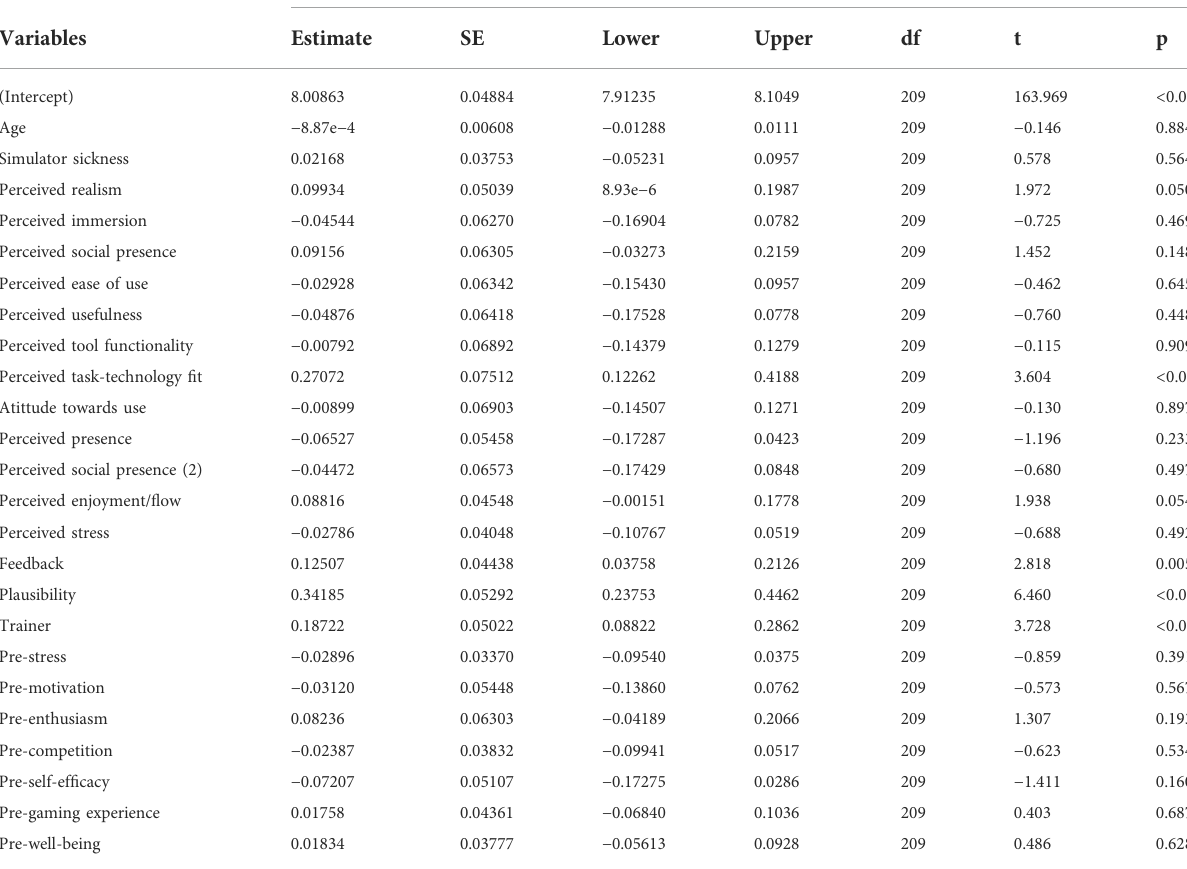
TABLE 7 In fl uence of age/rescue experience, learner state of mind, and learning experiences on perceived